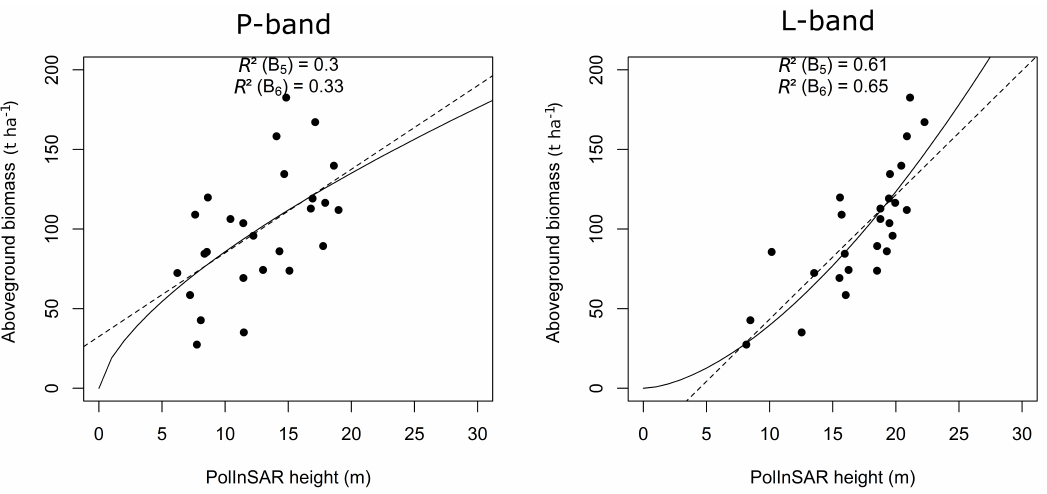
Figure 8. PolInSAR height and aboveground biomass regression based on P- ( left ) and L-band ( right ) in